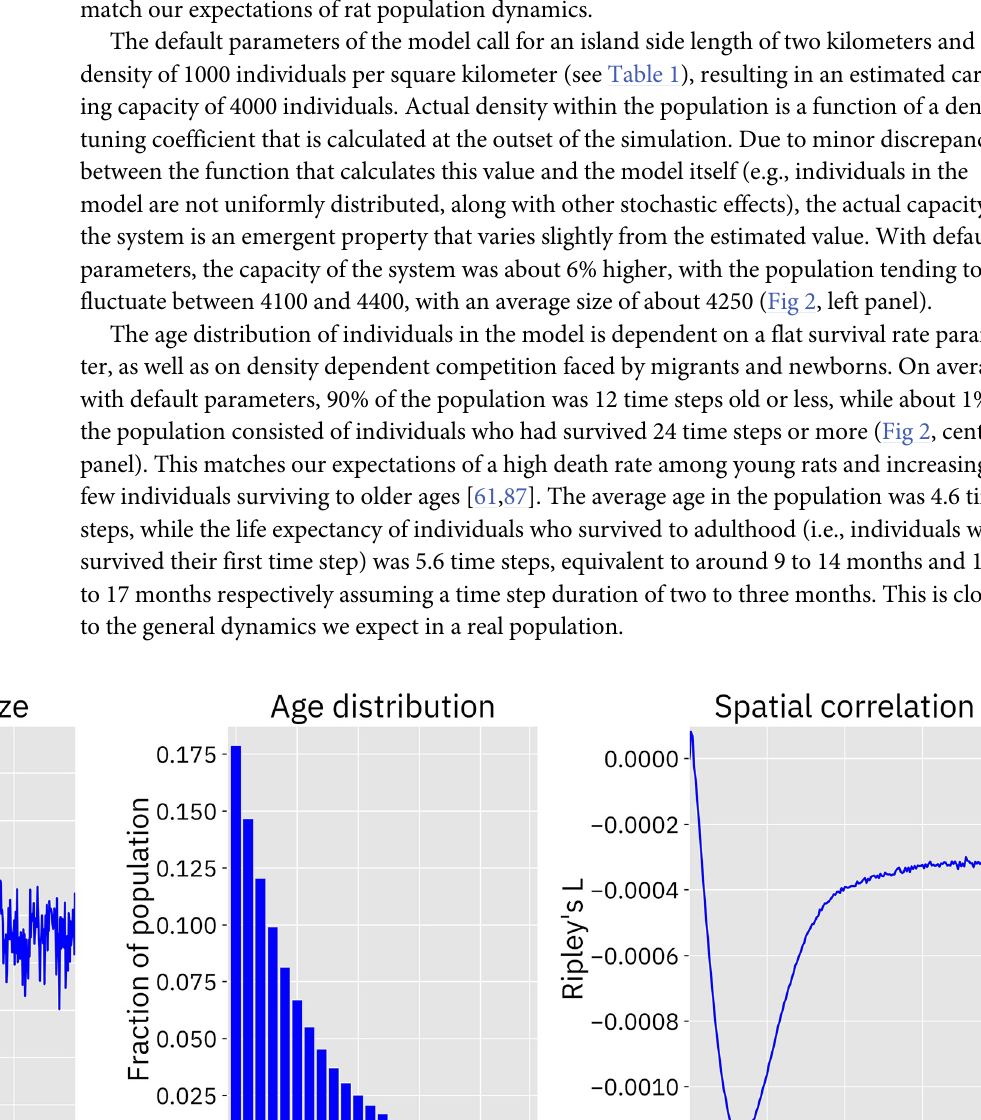
PLOS Computational Biology | https://doi.org/10.1371/journal.pcbi.1009660 December 29,